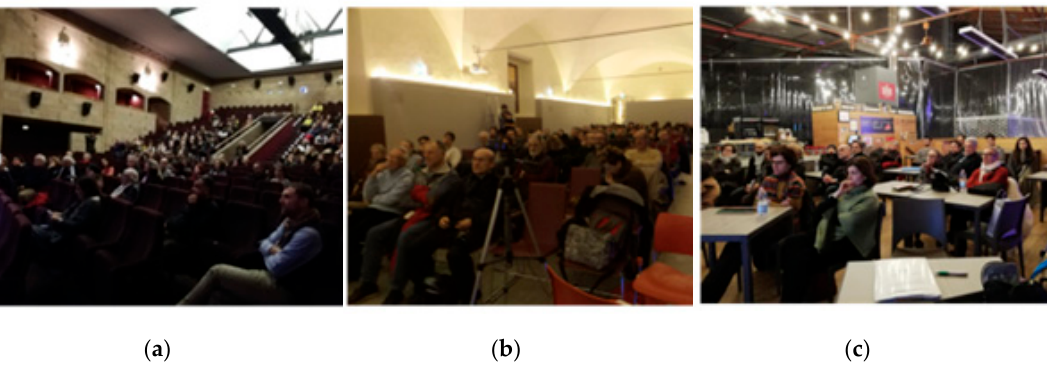
Figure 1. Different modalities of Science cafés: ( a ) in a conference room of the public Library “Oblate”, in the center of Florence; ( b ) a Cine-science at the Cinema “La Compagnia”, Florence; and ( c ) a science café in the Central Market of Florence.